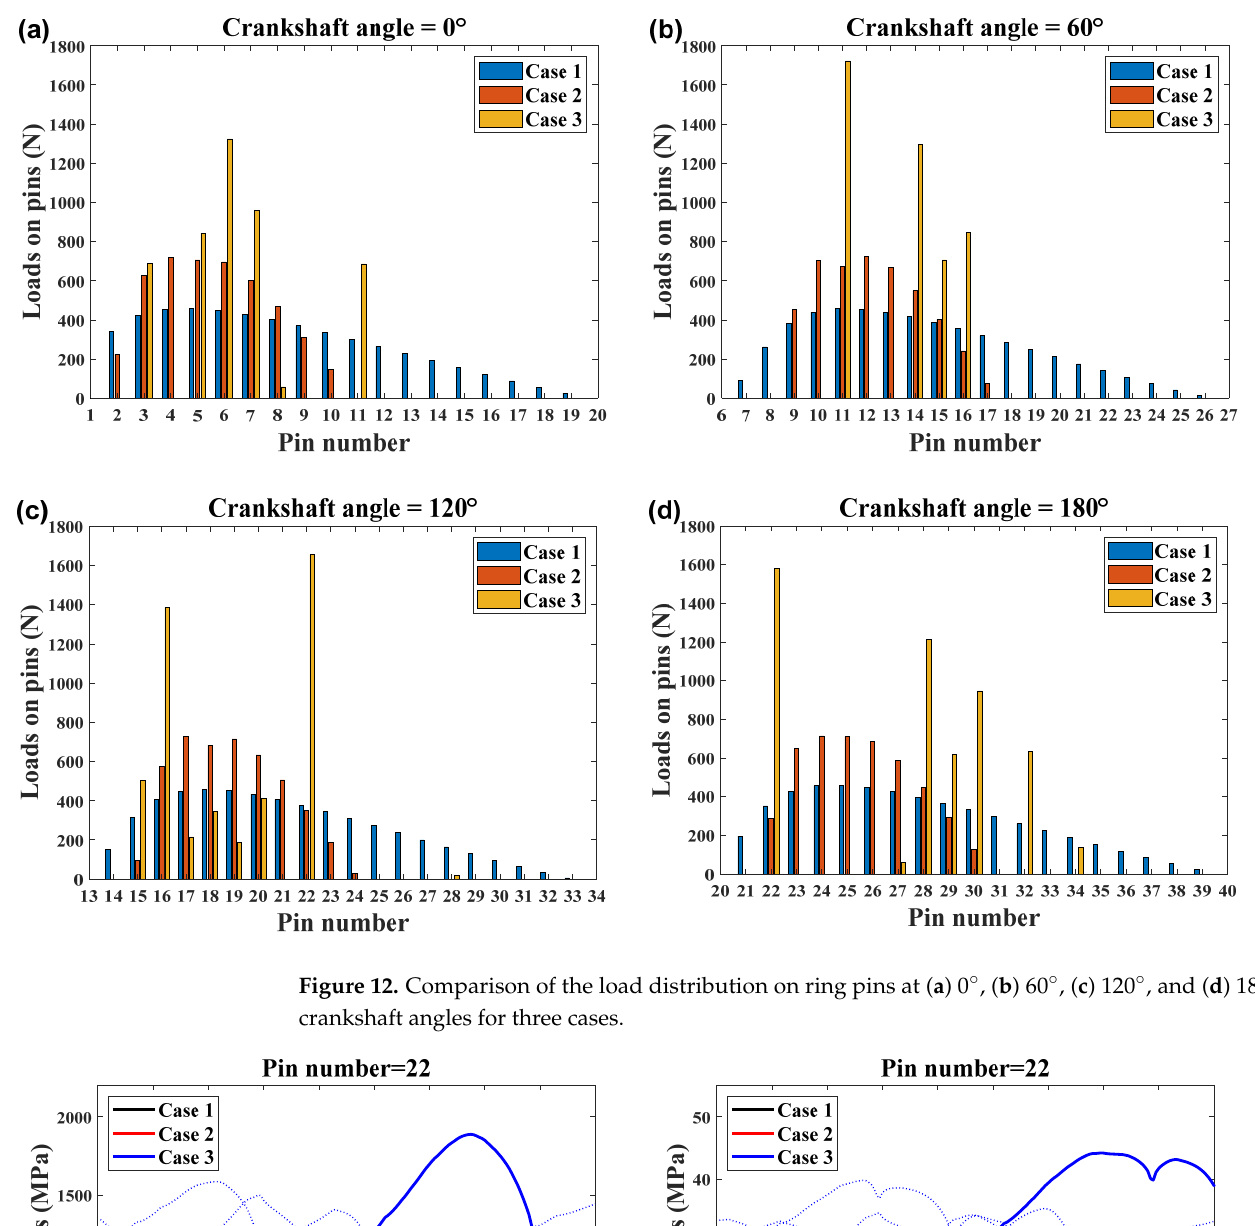
Figure 11. The random ( a ) angular and ( b ) radial position errors of all ring pins.